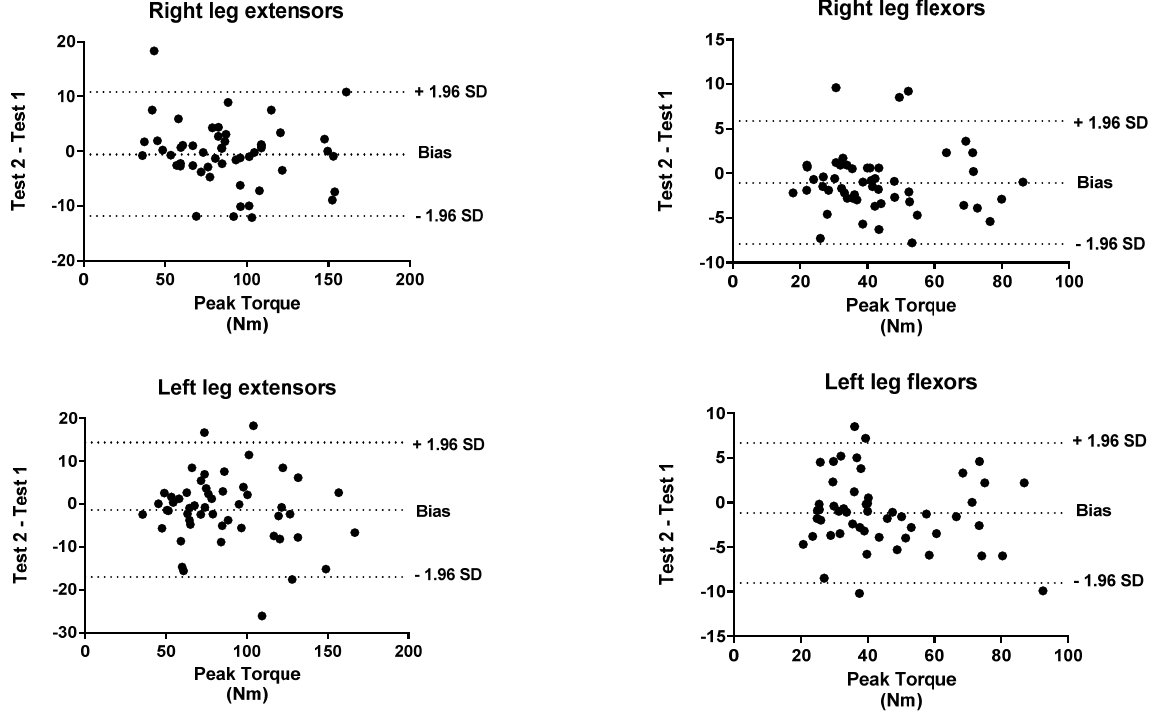
Figure 1. General Bland–Altman peak torque analysis for Right and Left Legs in flexion and Exten- sion.